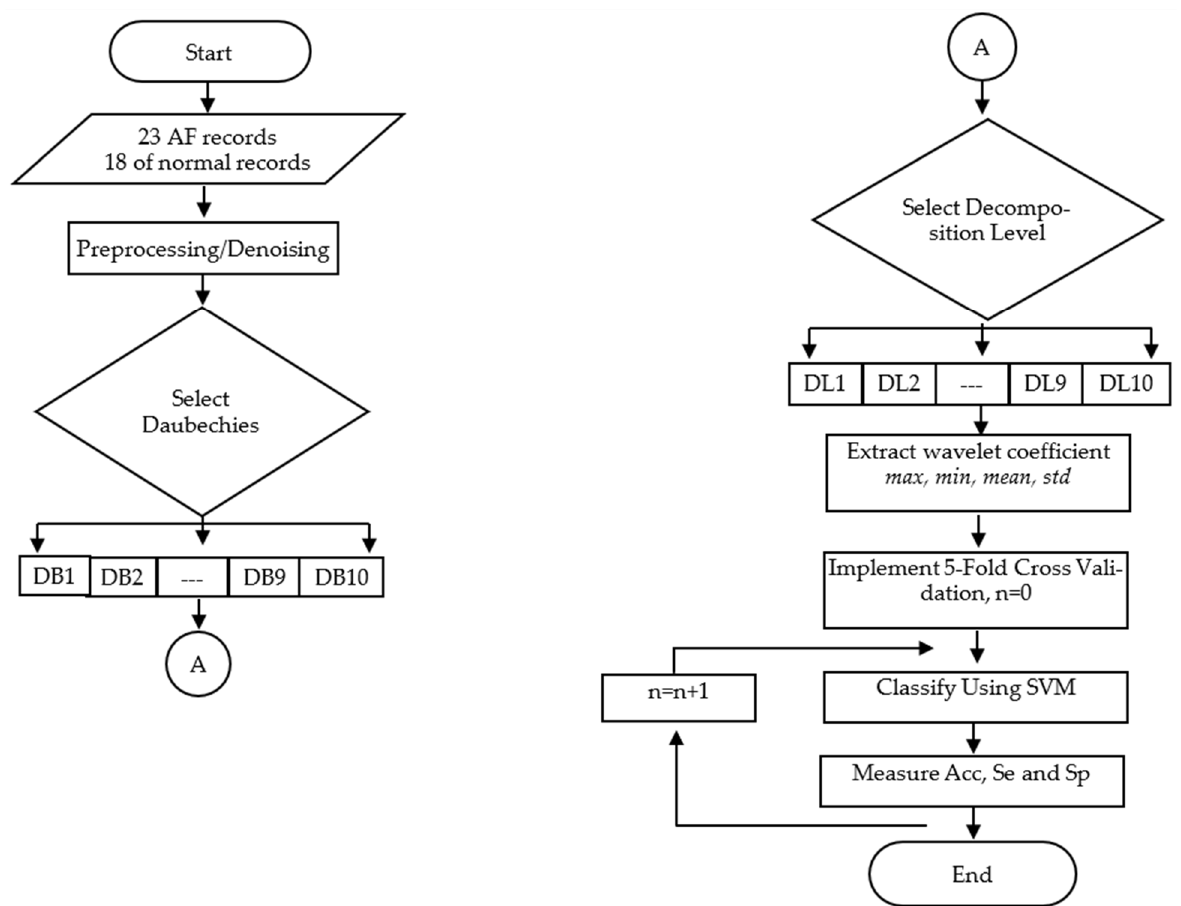
Figure 7. Experiment scenario for evaluating the effect of both DWBF and DL on detecting AF.